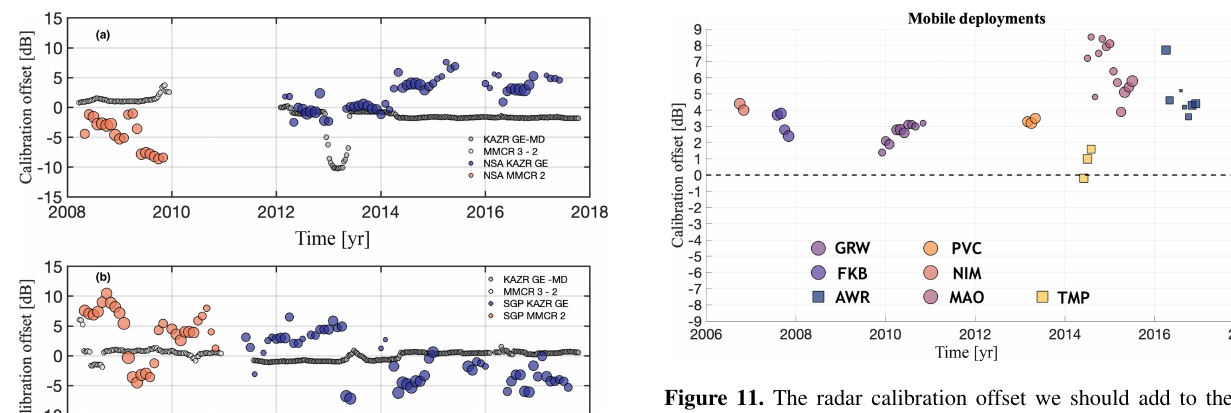
Figure 11. The radar calibration offset we should add to the re- ported ARM cloud radar reflectivities in order to minimize their dif- ferences with those reported by the CloudSat CPR at the ARM Mo- bile Facility (AMF) sites. The size of the circles indicates the ratio of the sample size of the CloudSat columns for any given calibration offset estimate relative to the maximum sample size of CloudSat columns observed during the same period by the same mode. Cir- cles correspond to 94GHz (WACR) calibration offsets and squares correspond to 35GHz (KAZR) calibration